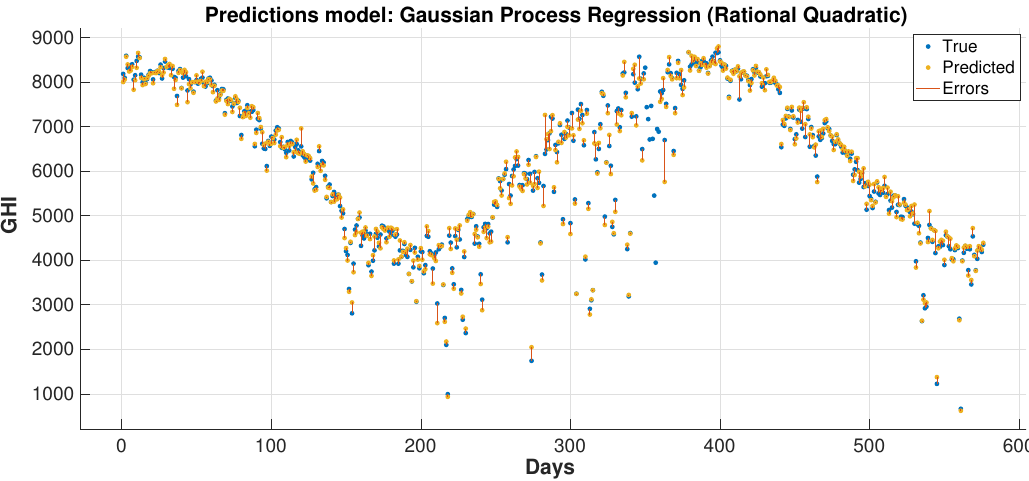
Figure 12. The predicted solar irradiance versus the real values for QU dataset without reduction.